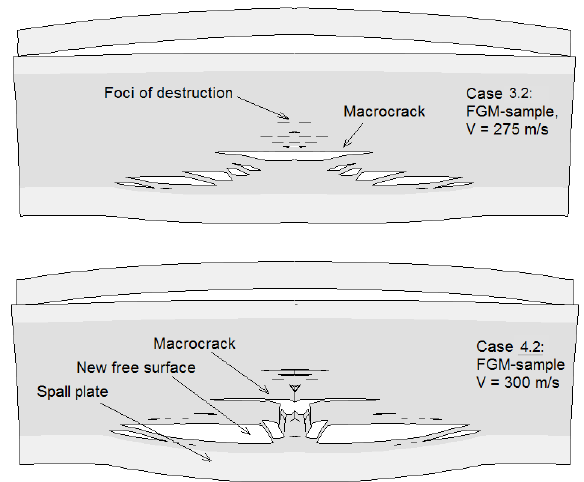
Fig. 8. Damage parameter Vs. Time. The arrows indicate the approximate location of the control points. The exact location is mentioned in section 4.